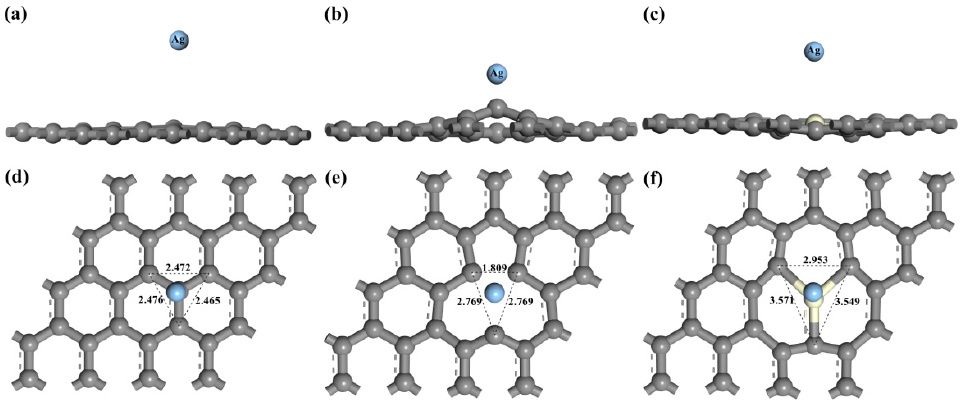
Figure 2. Geometric structures of graphene with the adsorbed Ag atom: ( a ) front view of intrinsic graphene; ( b ) front view of VG; ( c ) front view of Ce-doped graphene; ( d ) top view of intrinsic graphene; ( e ) top view of VG; ( f ) top view of Ce-doped graphene.